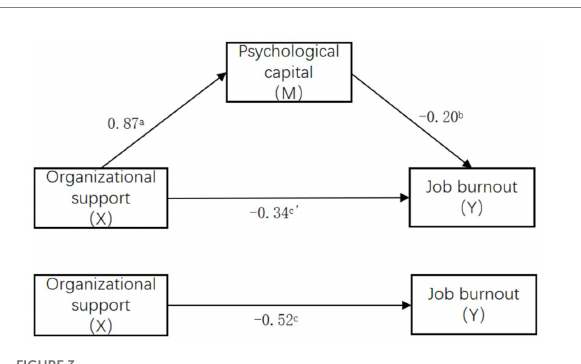
FIGURE 3 The intermediary path of psychological capital between perceived organizational support and job burnout ( n = 916, Shandong, China). a: direct effect of X on M; c’: direct effect of X on Y; a* b: indirect effect of X on Y; c: Total effect; p <